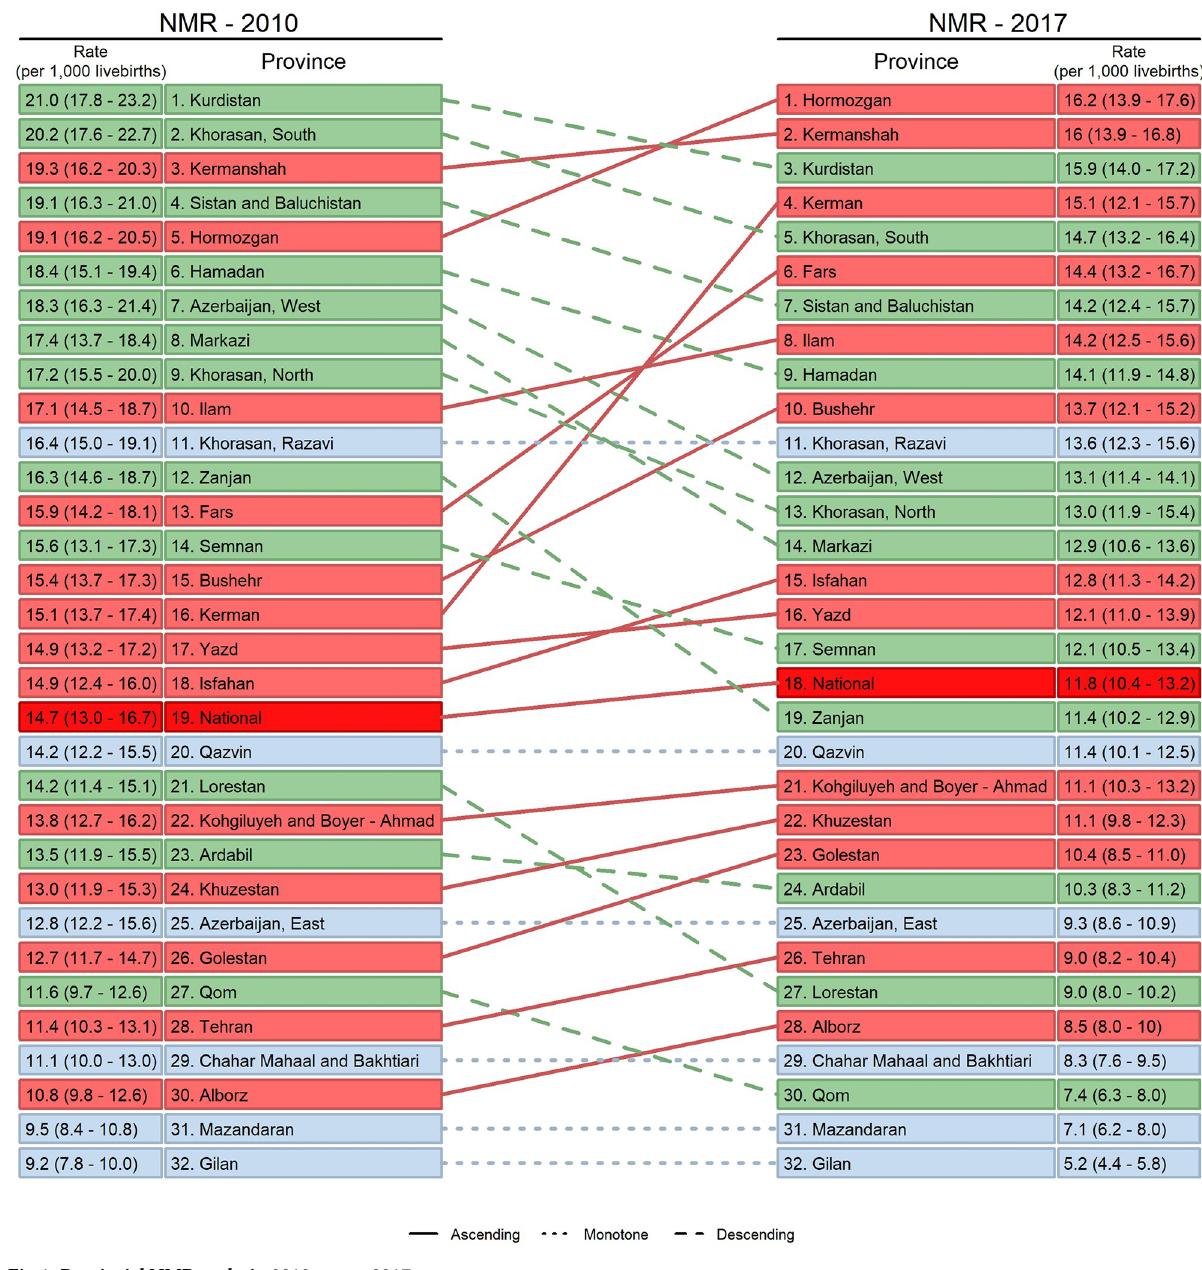
Fig 4. Provincial NMR ranks in 2010 versus